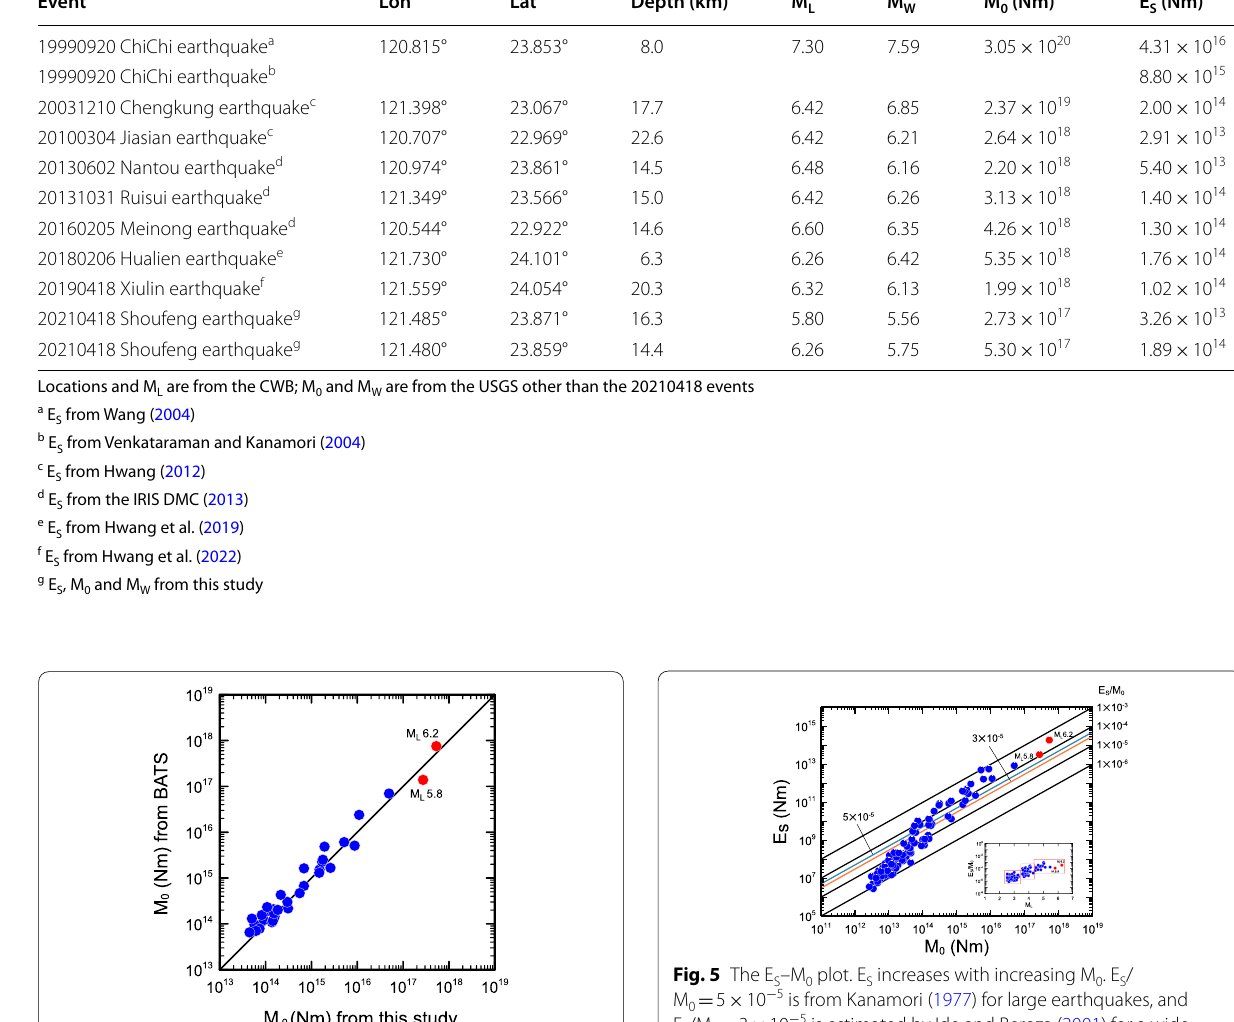
Table 1 Source parameters for moderate and large earthquakes in Taiwan